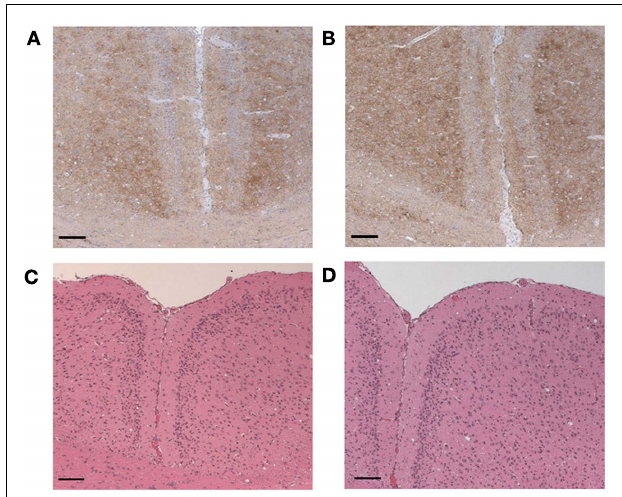
FIGURE 5 | PrP Sc accumulation in the brains of mice challenged with RML. Immunohistochemistry: moderate diffuse PrP Sc accumulation in the cerebral cortex and multifocally in the corpus callosum of both (A) untreated and (B) with tea treated mice. Detection was carried out with mab SAF 84. Bar 200 μ m. H&E staining: mild vacuolation in the cerebral cortex of both (C) untreated and (D) with tea treated mice, H&E staining, Bar 200 μ m.